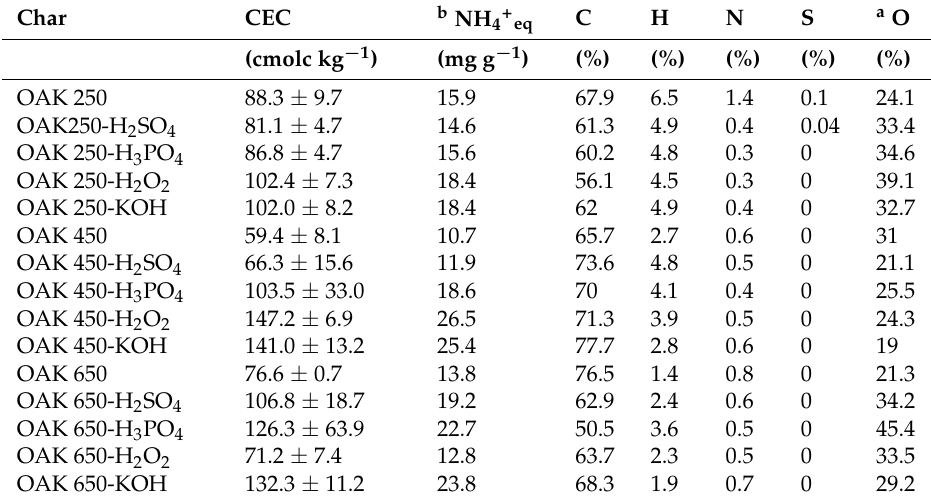
Table 2. Elemental content and CEC values for a selection of treated